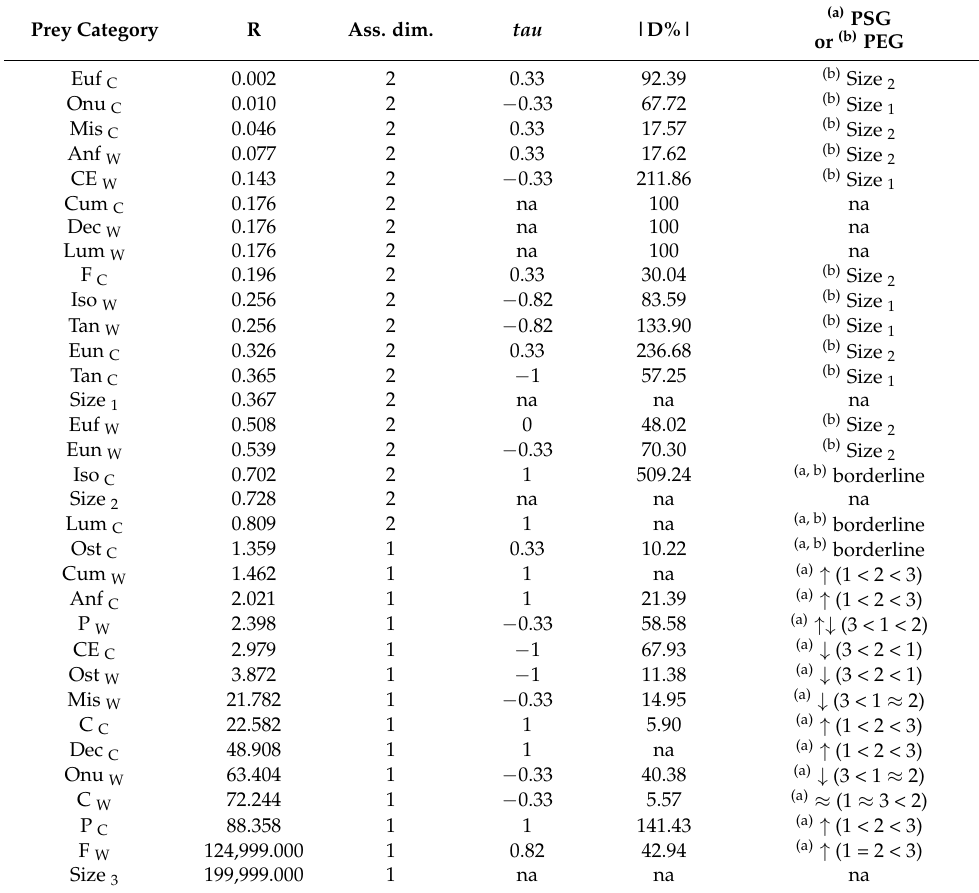
Table 2. Data used for interpretation of results from correspondence analyses run on values of the prey importance index (PII: F% * N%) of prey categories found in the stomachs of a seasonally collected sample of Coelorinchus caelorhincus caught on epi- and meso-bathyal grounds of the central Tyrrhenian Sea. R is the ratio between squared cosines of both row (predator’s sizes) and column (prey) points over dimension 1 and dimension 2, respectively. Ass. dim. is the most associated dimension to each row or column point. Tau is the Kendall’s rank correlation coefficient between mean size by size classes and PII values according to prey category in a given period. |D%| is the absolute value of percent difference in relative abundance (N%) calculated bilaterally between periods (C: cold, W: warm), as subscripts of prey categories, for macro-taxa prey categories (C: Crustaceans; P: Polychaetes; F: Fish; CE: Cephalopods;) and for micro-taxa prey categories (Eun: Eunicids; Ost: Ostracods; Anf: Amphipods; Mys: Mysids; Onu; Onuphids; Tan: Tanaids; Lum; Lumbrinerids; Dec: Decapods; Euf: Euphausids; Cum: Cumaceans; Iso: Isopods). PSG and PEG stand for Prey-Sharing Gradient and Prey-Exclusivity Gradient, and corresponding letters ( a ) and ( b ) as superscripts indicate which of the two gradient prevails for a given prey by a given period in the corresponding column. Symbols ↑ , ↓ , and ≈ stand for PII monotonically increasing, decreasing and about constant, respectively, along sizes of the predator. Sizes are size classes of the predator and numbers 1 , 2 and 3 indicate small (20–35 mm), intermediate (36–50 mm) and large (51–86 mm) specimens, respectively. NA: not